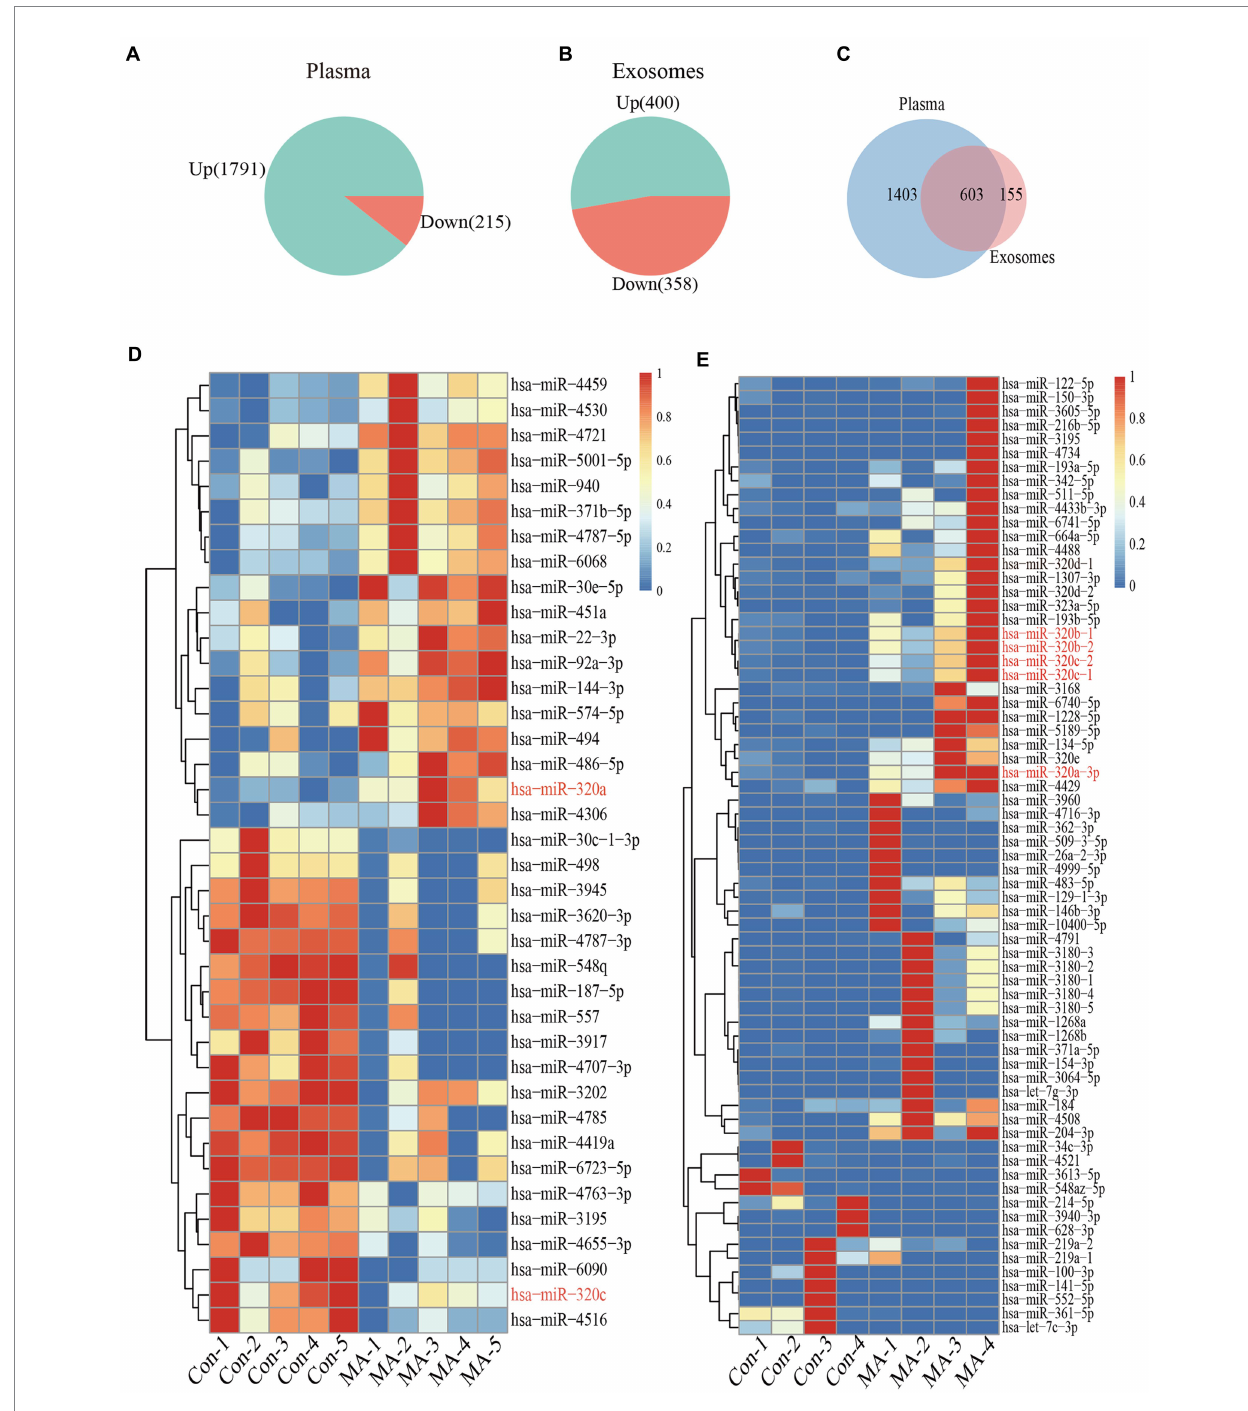
FIGURE 2 Plasma and exosomal miRNAs profiles are different in MA use disorder patients and healthy controls. Increase or decreased plasma (A) and exosomal (B) miRNAs with increases or decreases in MA use disorder patients relative to healthy controls are depicted in green or red, respectively. Venn diagrams (C) showed miRNAs that increased or decreased in the plasma and exosomes of subjects, and the overlap miRNAs were altered in the plasma and exosomes of subjects. Heatmap of miRNAs profiles from plasma ( n = 5 in each group) (D) and exosomes ( n = 4 in each group) (E) samples of MA- dependent patients and healthy control subjects. Red indicates up-regulation; blue indicates